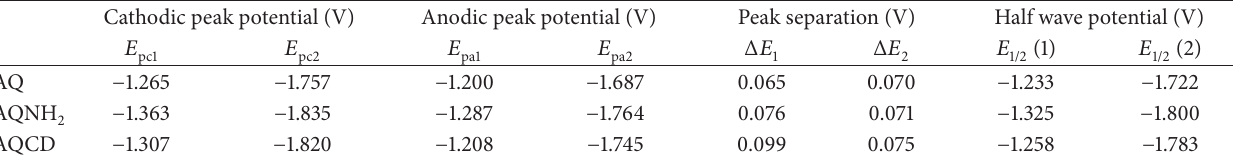
/CH CN. Scan rate: 50 mV/s. 6 3